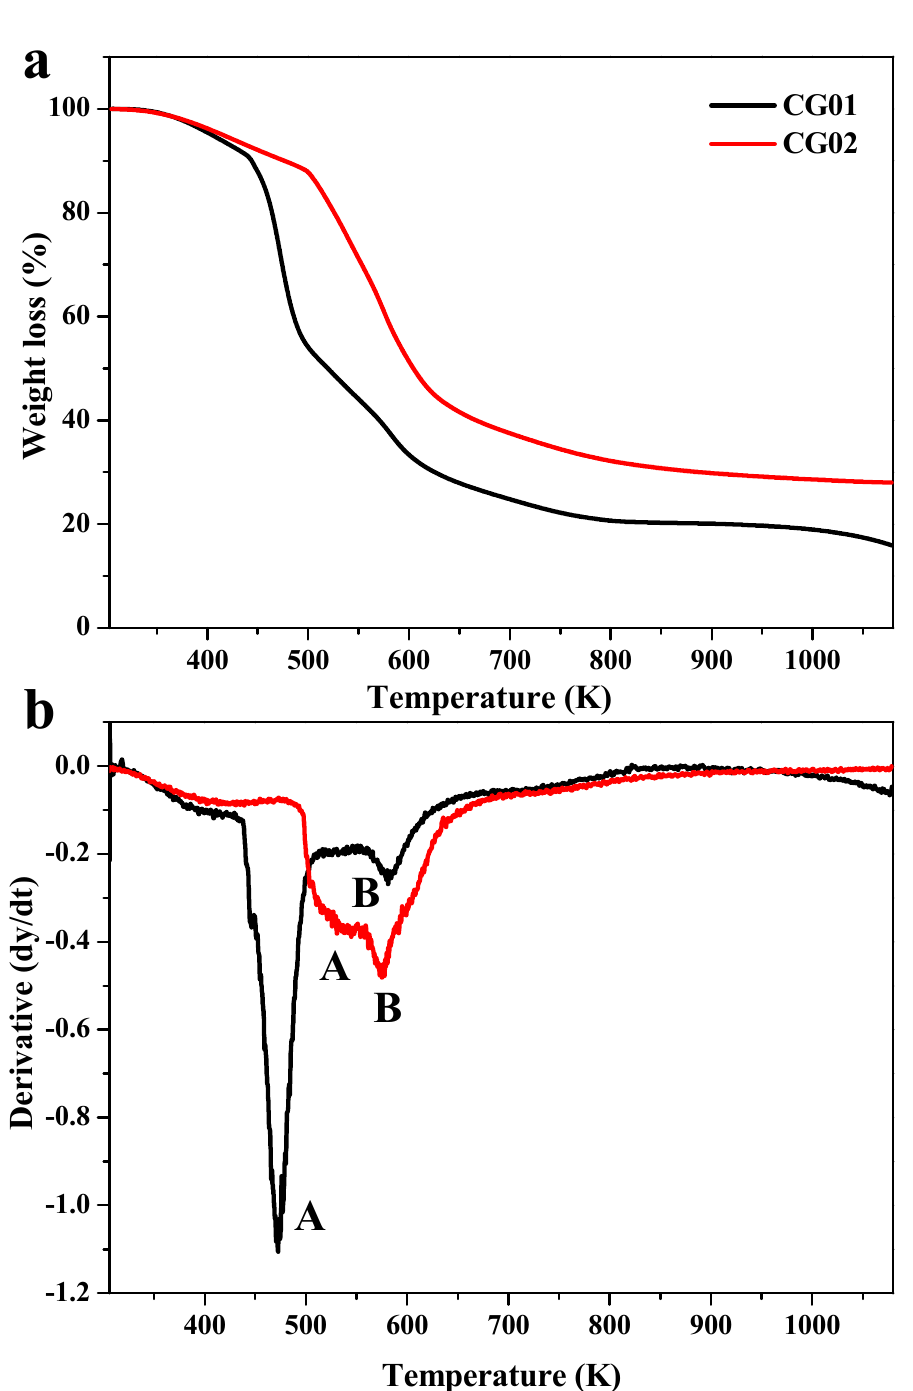
Figure 6. Thermogravimetric analysis of CG01 and CG02 hydrogels ( a ) TGA curve, and ( b ) its first derivative showing clearly the difference in the peak at 470 K.